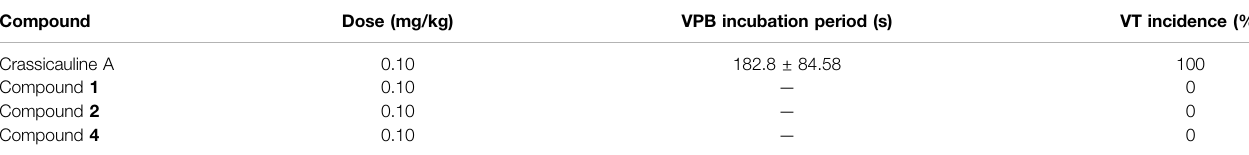
TABLE 4 | Comparison of cardiotoxicity between crassicauline A and its converted products. Compound